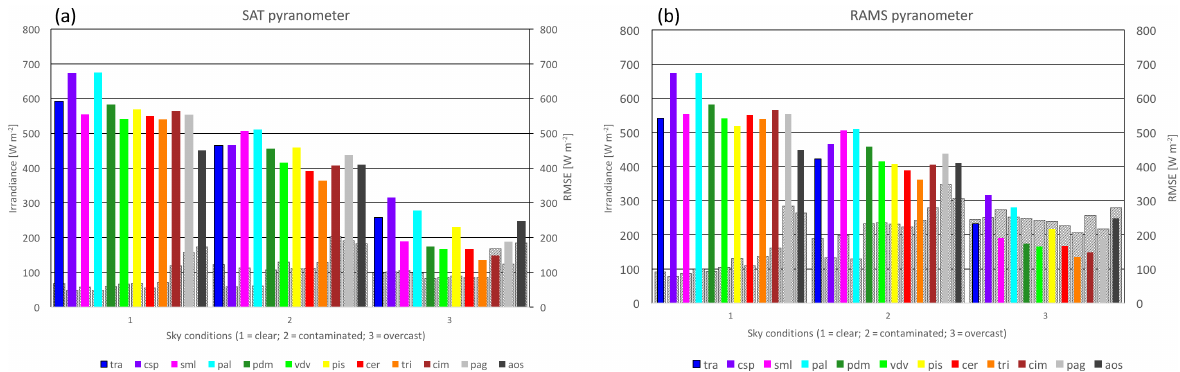
Figure 4. (a) Mean irradiance (coloured bars) and RMSE (grey bars) for different sky conditions: clear (1), contaminated (2), and overcast (3) for the MSG-GHI estimate. The figure has been derived from the hourly data of pyranometers and MSG-GHI estimate. The RMSE is shown with the same scale as the mean irradiance; (b) as in (a) for the RAMS-GHI 1-day hourly forecast.